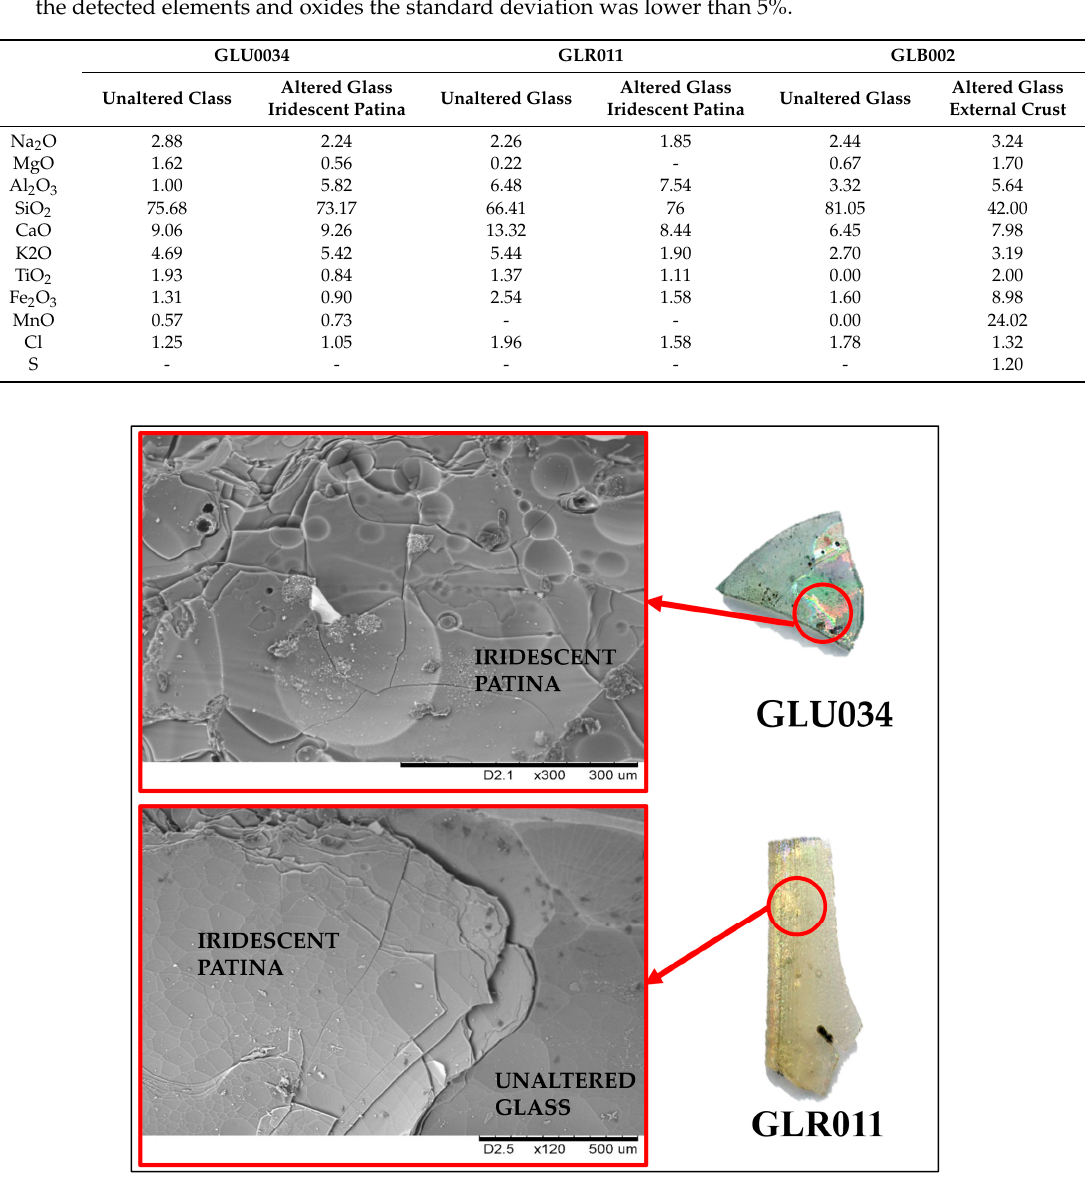
Figure 2. SEM images acquired on the iridescent surface of GLU034 and GLR011 samples.